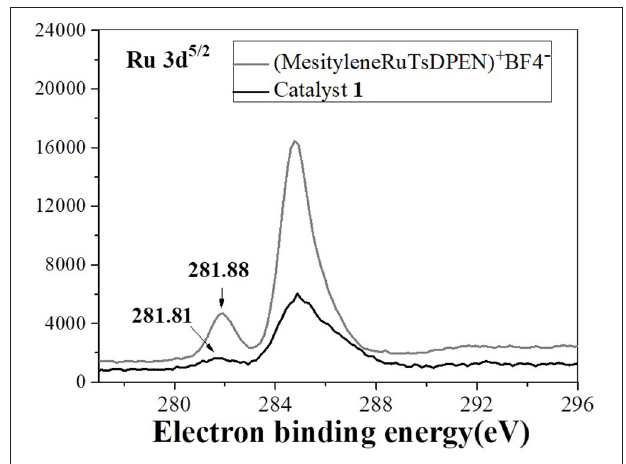
FIGURE 5 | The XPS spectra of the homogeneous (MesityleneRuTsDPEN)BF 4 and catalyst 1 .